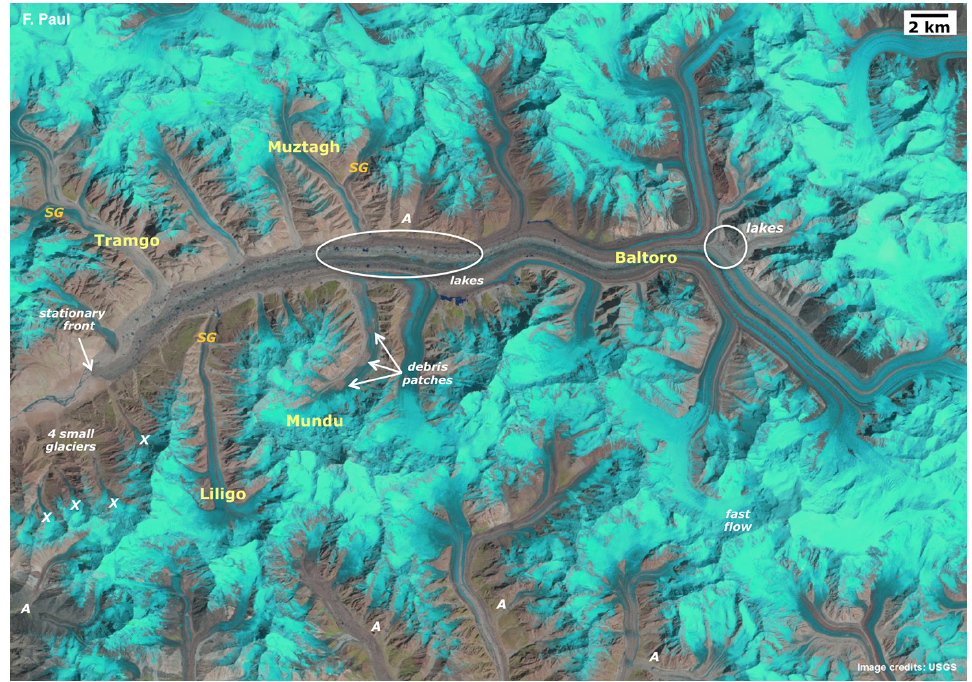
Figure 2. Subregion (1) (Baltoro) shows the tongue of Baltoro Glacier and its surrounding tributaries. SG (orange): actively surging glacier, SG (white): surge-type glacier (only on Figs. 4 and 5), A: advancing glacier. The Landsat scene 148-035 is from 14 August